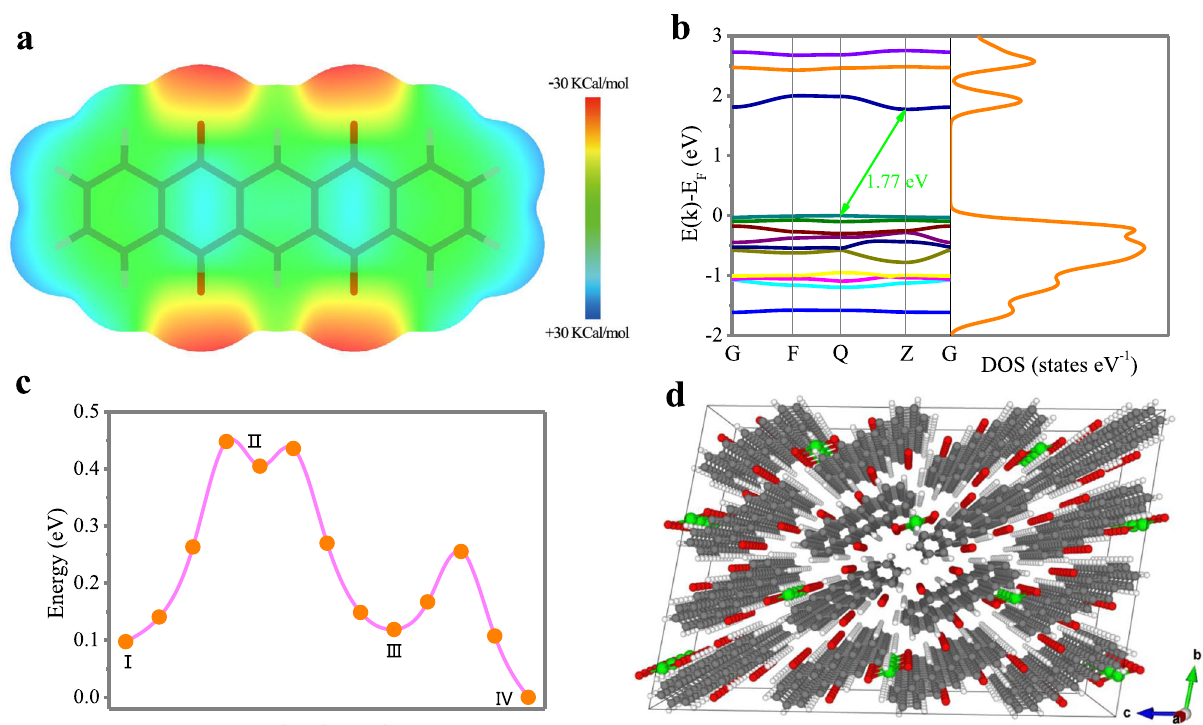
Fig. 6 Theoretical calculations of the Ca-ion storage in a PT crystal. a The MESP-mapped molecular van der Waals surface of PT. b the band structure and DOS of PT. c The diffusion pathway of a Ca ion con fi ned within the channel of PT crystal. d Perspective view of a (4 × 4 × 10) Ca-inserted PT supercell with a PT: Ca concentration of